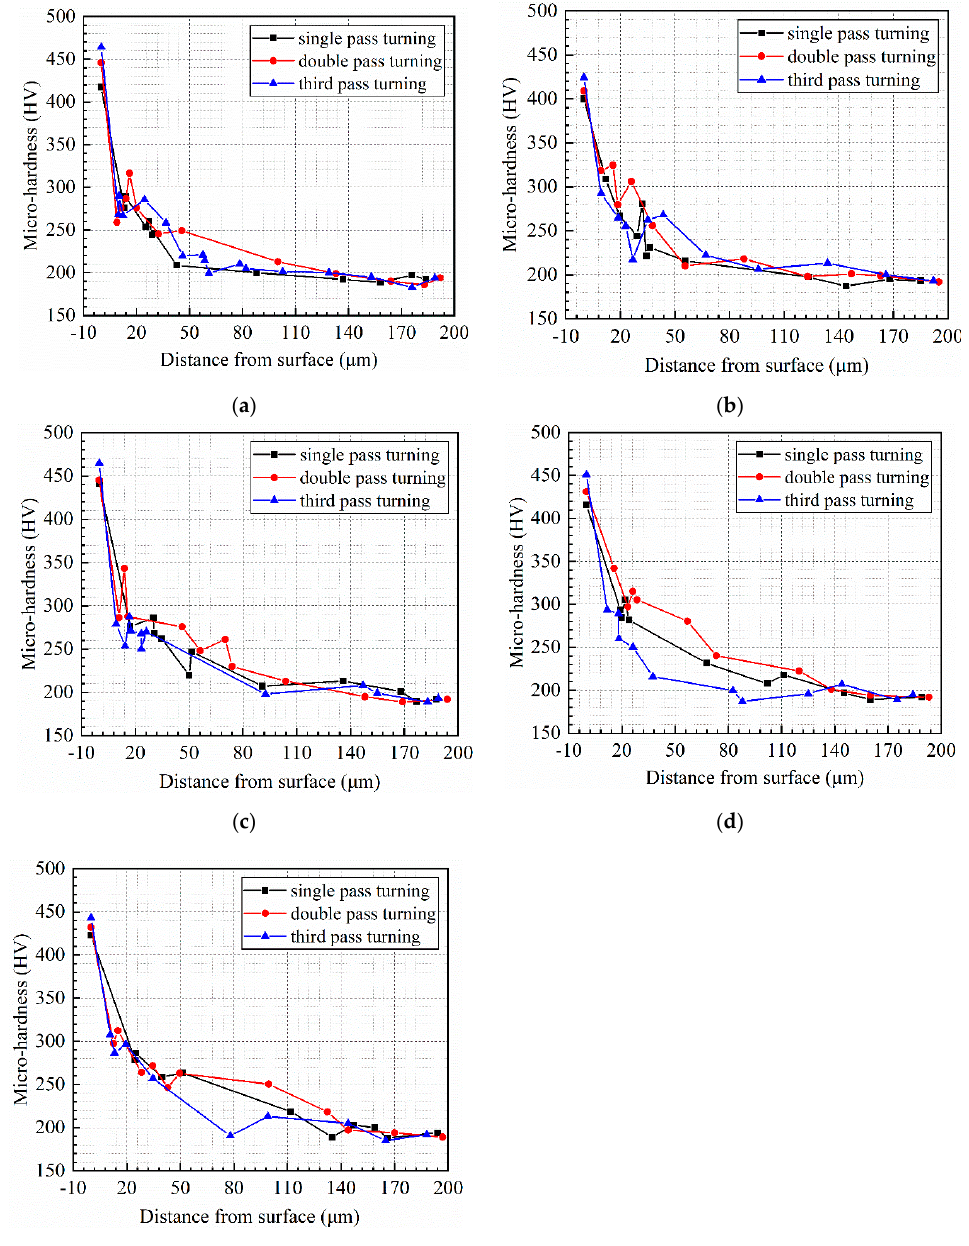
Figure 9. Profile of micro-hardness distribution under multi-pass turning conditions: ( a ) turning No. of T1, T6, and T11, ( b ) turning No. of T2, T7, and T12, ( c ) turning No. of T3, T8, and T13, ( d ) turning No. of T4, T9, and T14, ( e ) turning No. of T5, T10, and T15.